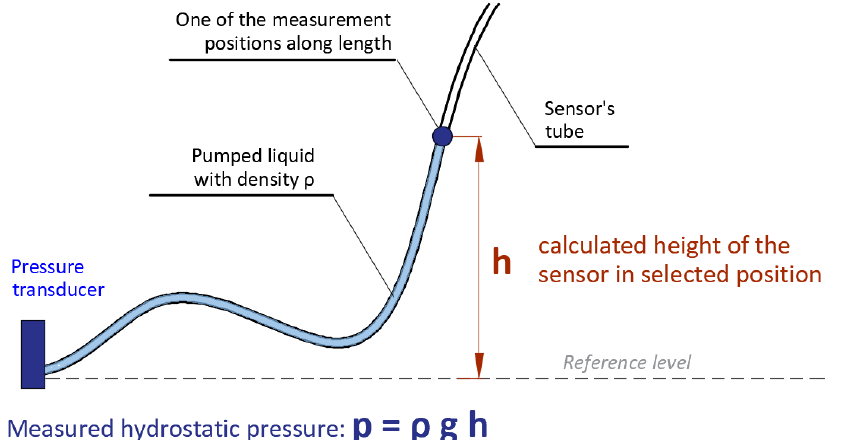
Figure 2. Basic operating principle for determining height by measuring hydrostatic pressure of the liquid column in selected position of the tube.